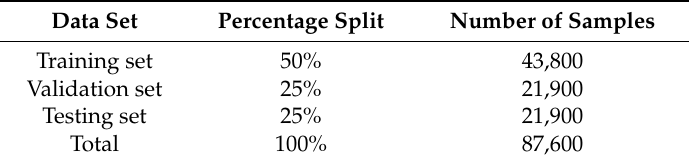
Table 2. Summary of training, validation and testing data sets.